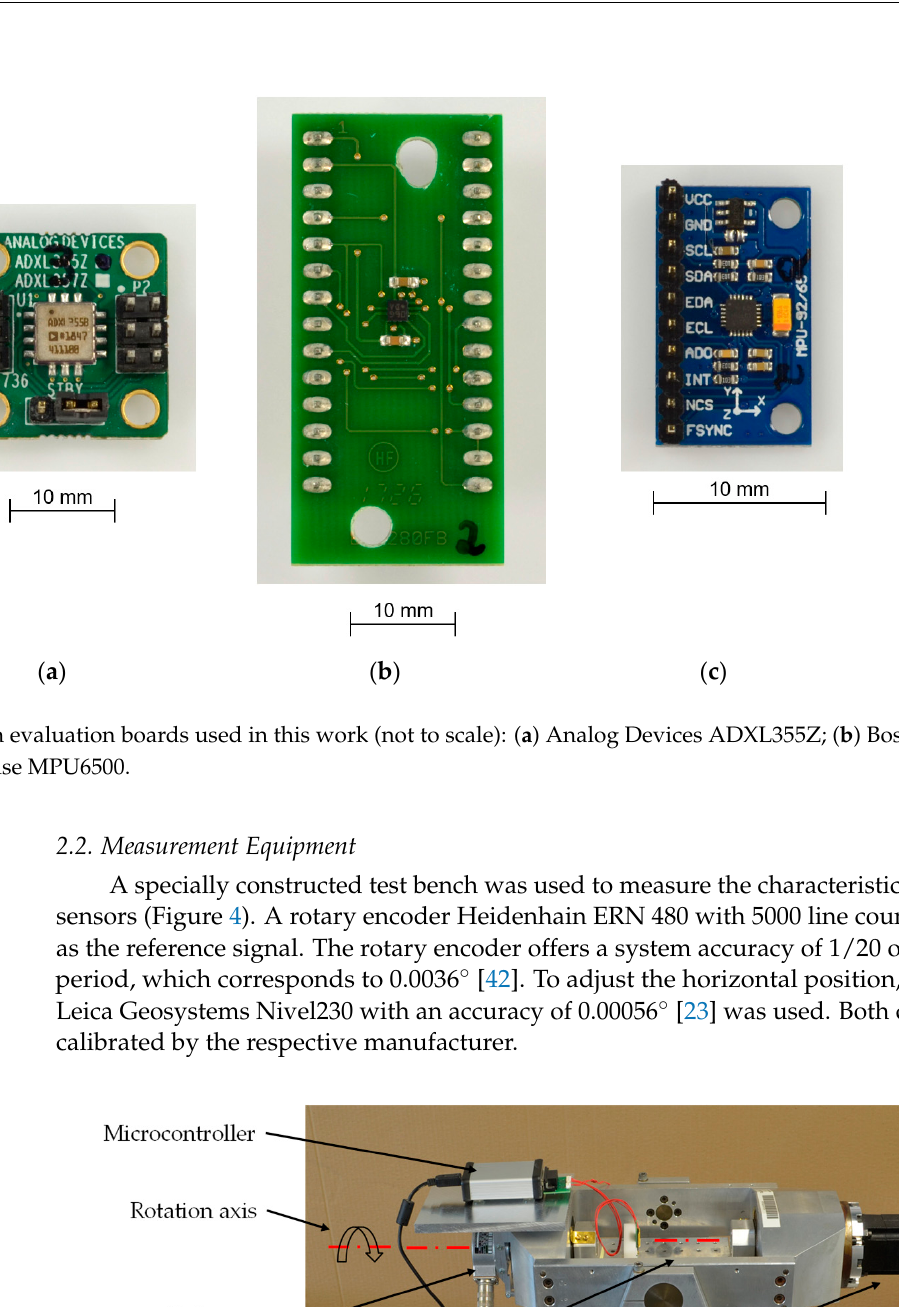
Figure 3. Sensors with evaluation boards used in this work (not to scale): ( a ) Analog Devices ADXL355Z; ( b ) Bosch BMA 280; ( c ) TDK InvenSense MPU6500.